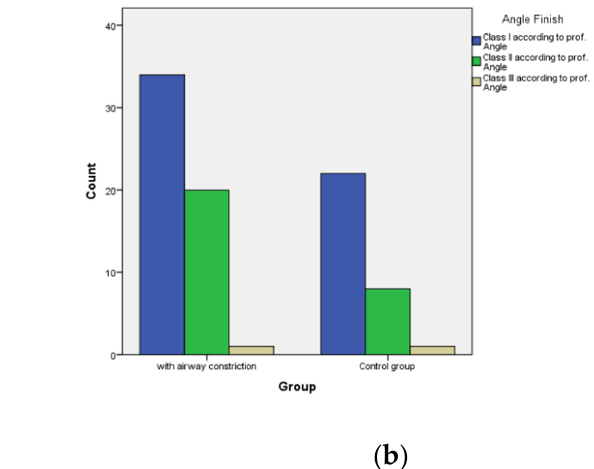
Figure 6. Distribution in Angle classification. ( a ) Initial scan shows Class II as the dominant group in patients with constricted airways as well as in the unconstricted control group. ( b ) At the finishing stage, the majority in both groups were patients in the first Angle Class, although Class II persisted due to strict evaluation of molar relationship, including extraction cases, unilateral Class II or non-surgical camouflage treatments in adults.